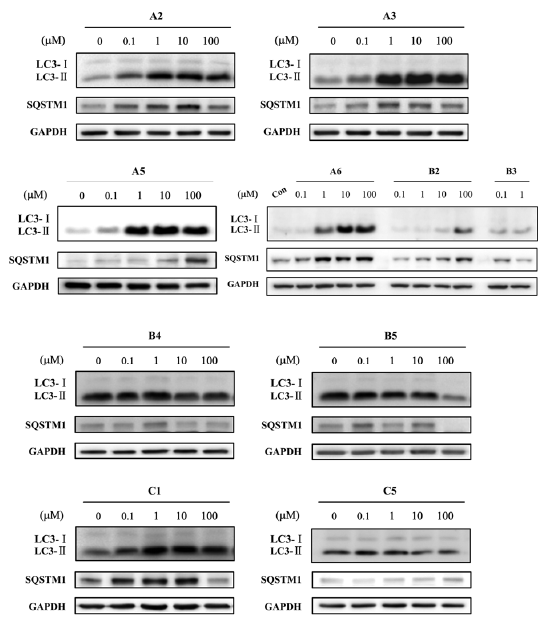
Figure 4. Synthesized vacuolin-1 analogues induced the accumulation of both LC3B-II and SQSTM1 in HeLa cells in a dose dependent manner after a 6 h treatment. Table 2. SAR of synthesized compounds a